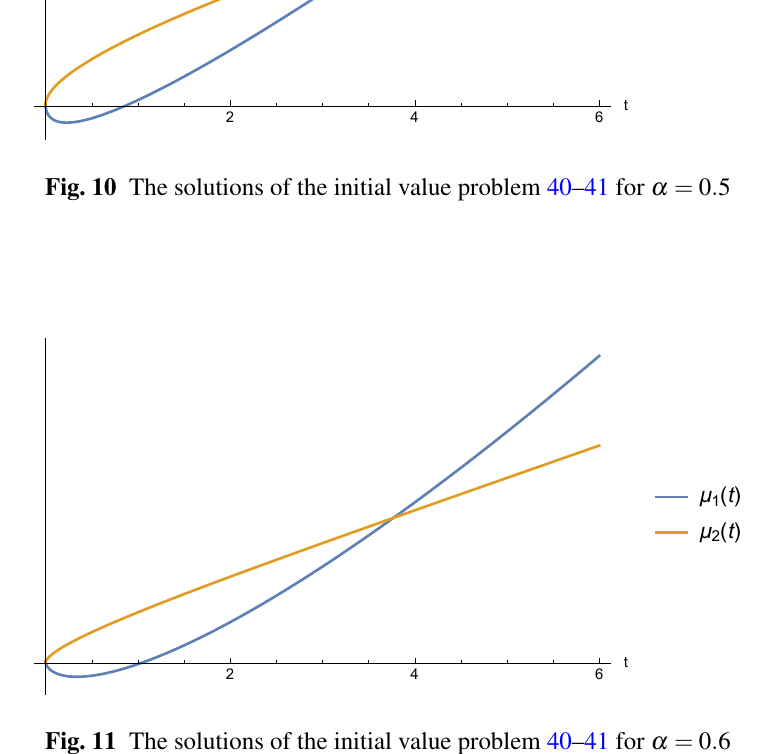
Fig. 11 The solutions of the initial value problem 40–41 for α = 0 .